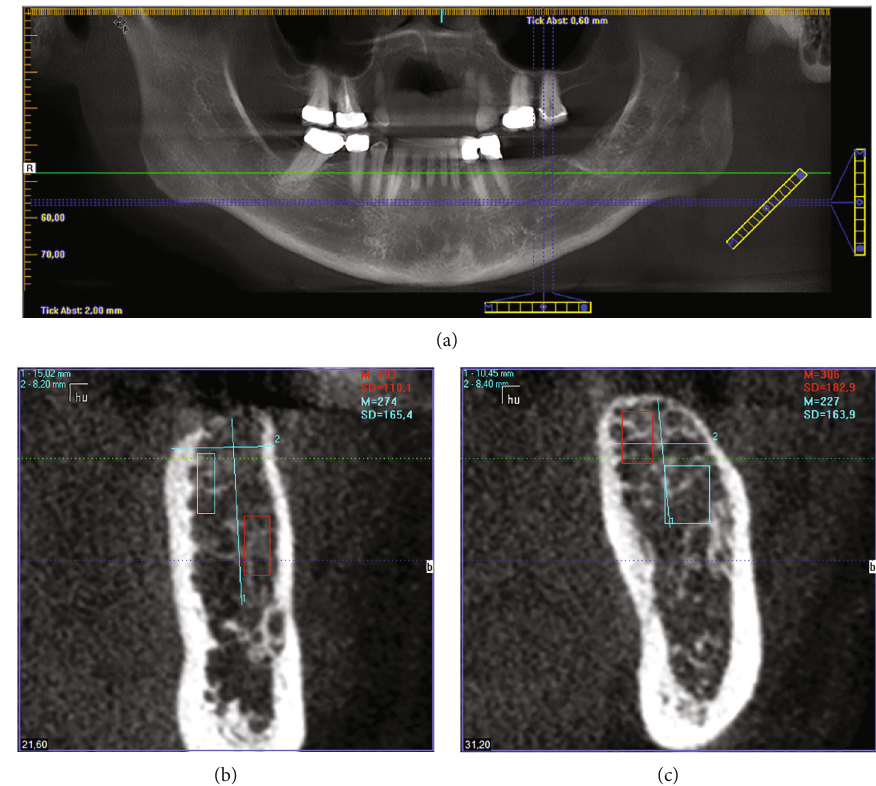
Figure 2: An OPT and a vertical section in the region of the implants to be inserted were derived from the DVT.